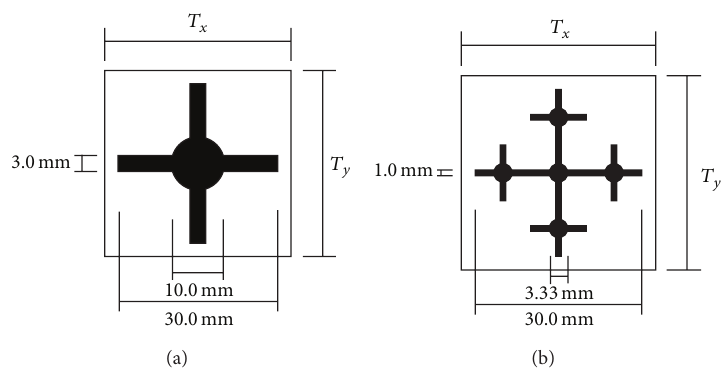
Figure 1: Cross fractal FSS elements: (a) generator and (b) first fractal iteration.